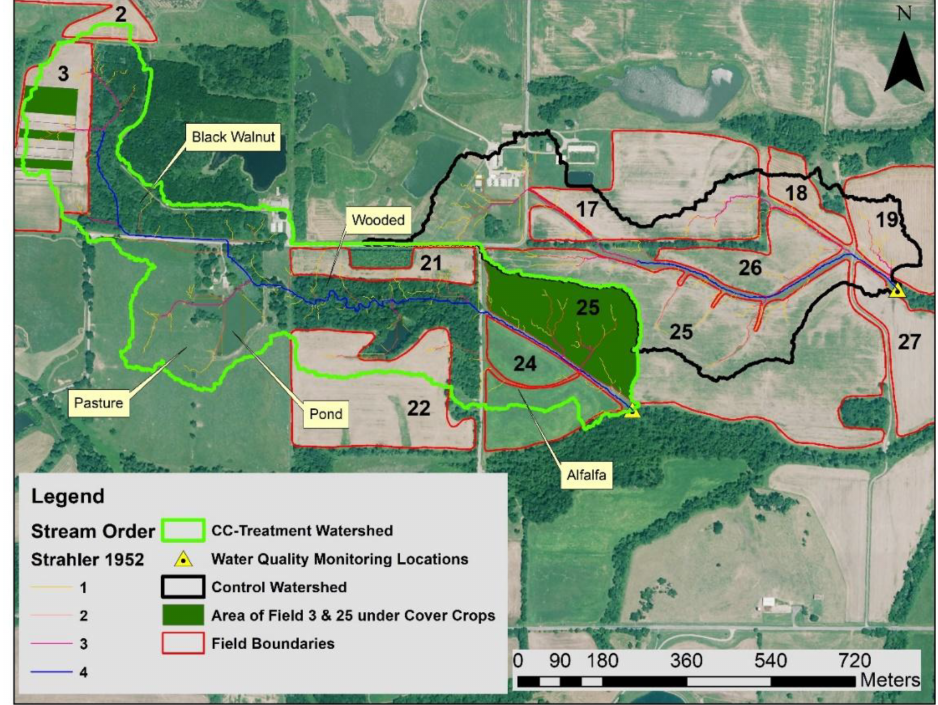
Figure 1. Paired watershed research site at Southern Illinois University’s research farms in Carbondale, IL, USA. The control watershed has an area of 27 ha and contains field numbers: 17, 18, 19, 25, 26, and 27. The cover crop treatment (CC-treatment) watershed has an area of 42 ha and contains field numbers: 2, 3, 21, 22, 24 and